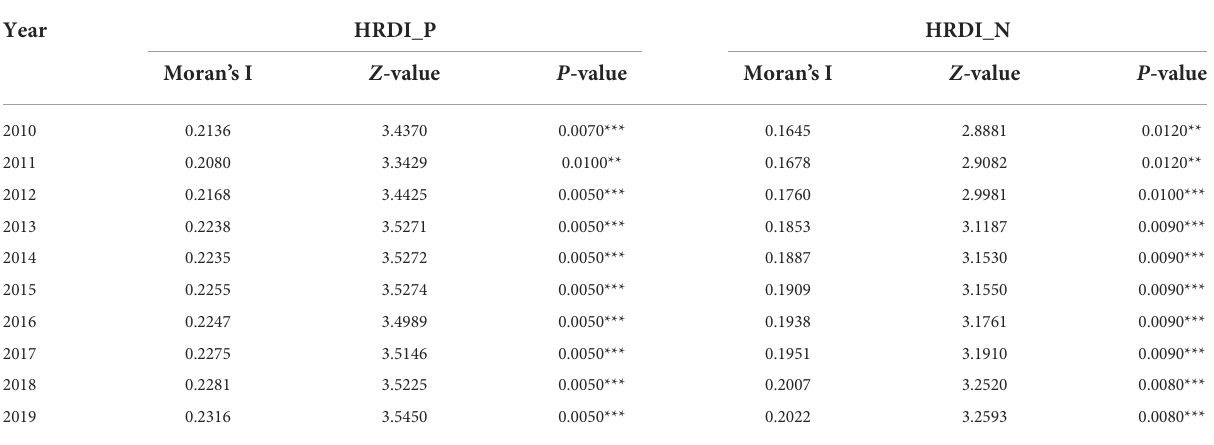
TABLE 3 Global Moran’s I index of HRDI_P and